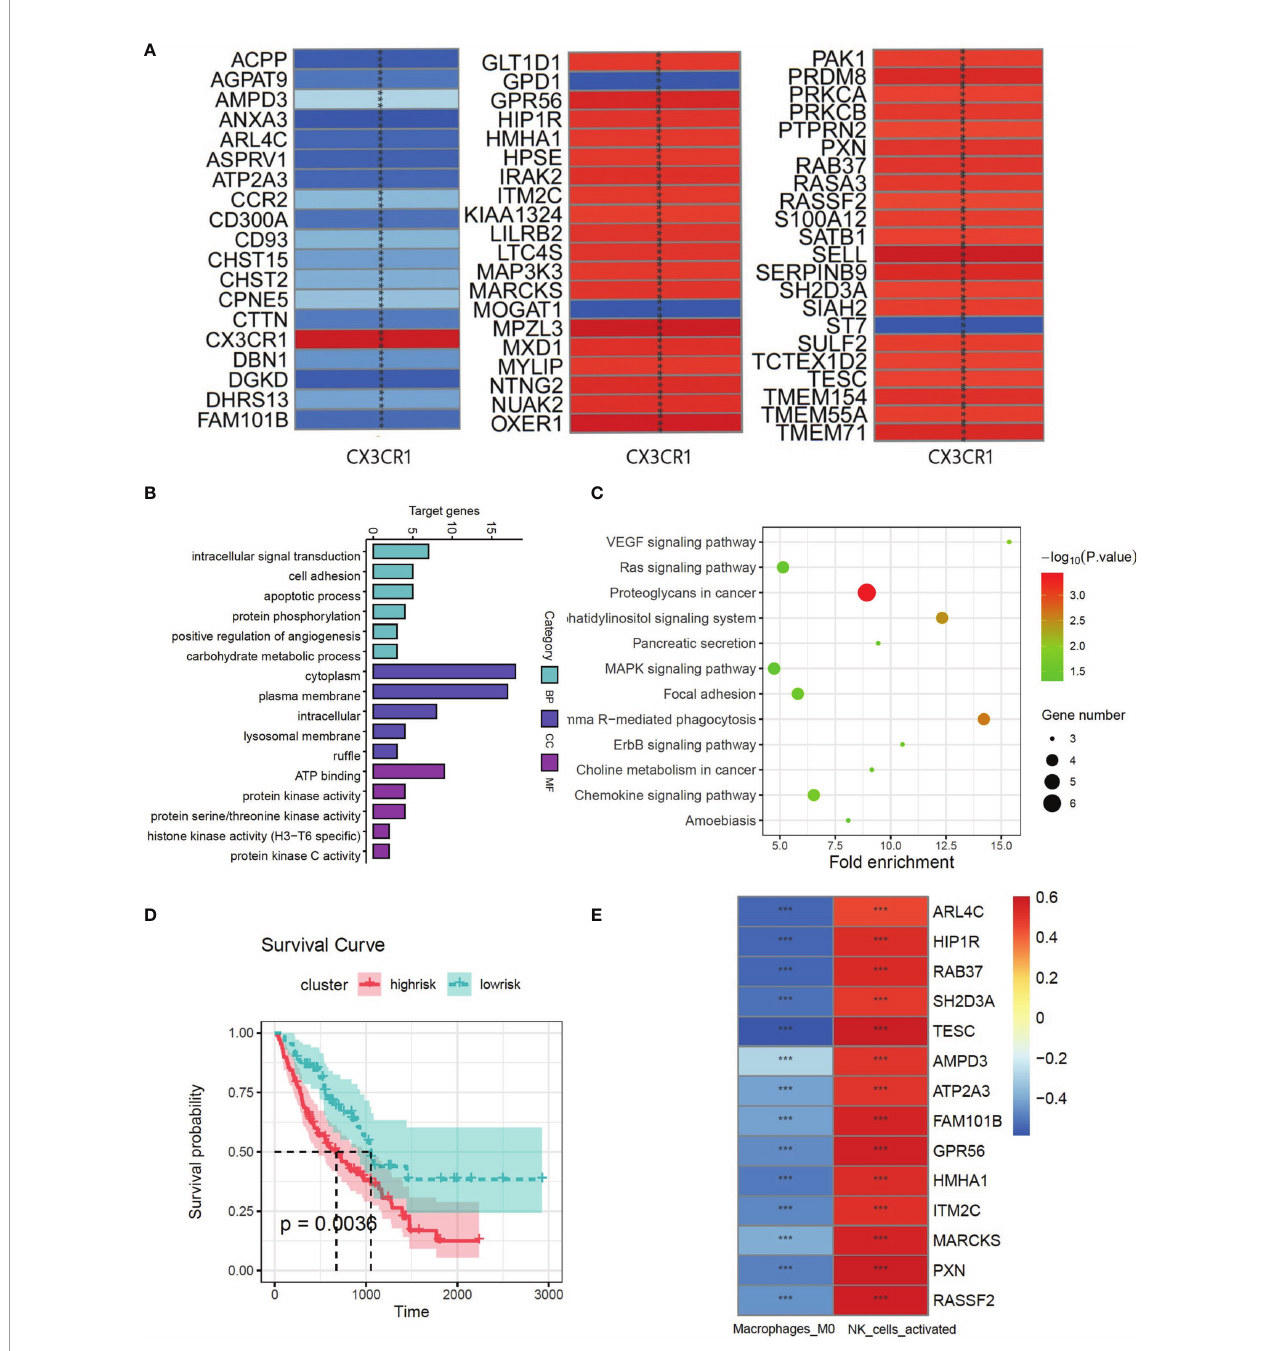
FIGURE 3 | (A) The correlations between the CX3CR1 and genes which screened by univariate Cox analysis from whole genome. (B) GO function enrichment histogram of CX3CR1-related genes. (C) KEGG pathway bubble diagram of CX3CR1-related genes. (D) Kaplan – Meier plot of overall survival in two clusters based on the risk models of ESTIMATE immune score. (E) The correlations between the CX3CR1-related genes and 2 immune cell compositions. *** means P <